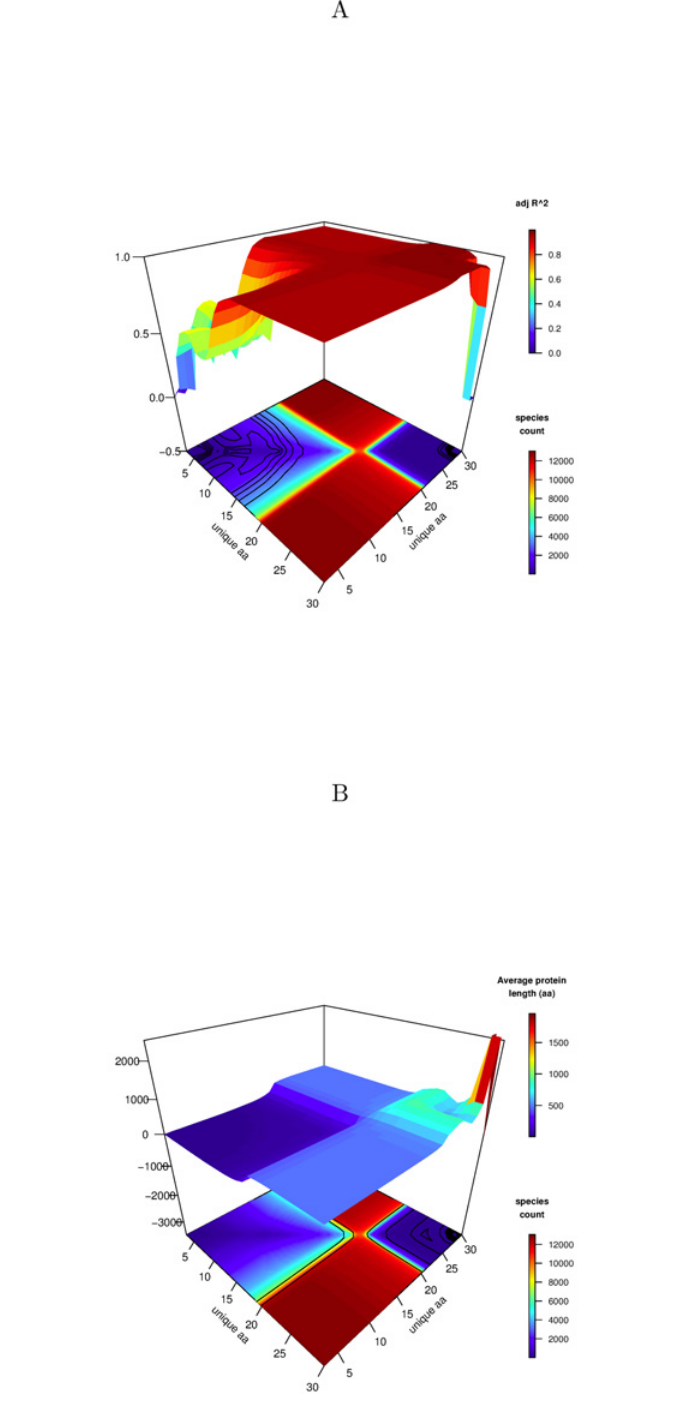
Fig 2. Adjusted R 2 and average protein length distribution with unique amino acid count. A A plot of the adjusted R 2 against the range of unique amino acid counts. Each point on the surface corresponds to the R 2 match of all species for those proteins which fall in the unique amino acid count specified. The lower part of the plot contours the number of contributing species. B A plot of the average protein length for all species against the range of unique amino acid counts. The lower part of the plot contours the number of contributing